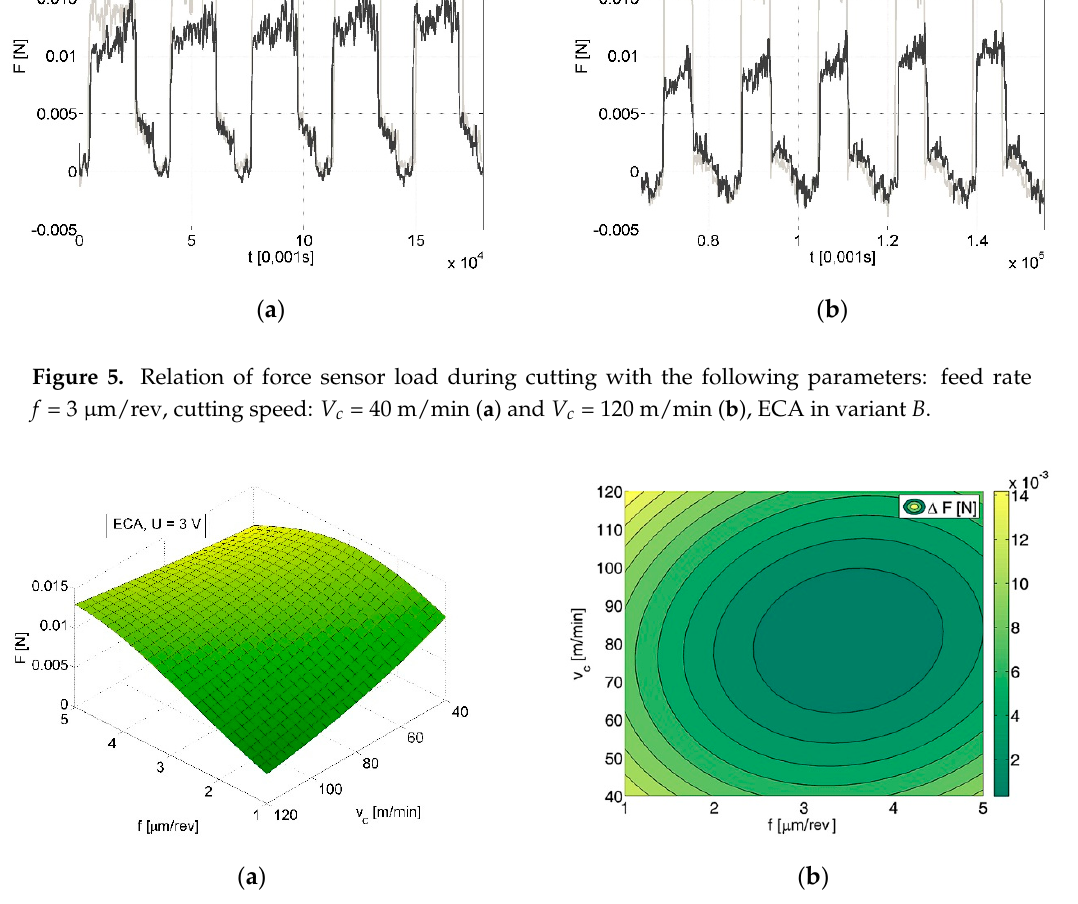
Figure 6. Relationship between ( a ) the sensor load and cutting speed V c and feed rate f ; ( b ) contour map of the sensor load decrease Δ F (relation between Δ F , cutting speed V c , and feed rate f ); machining with ECA in variant B .